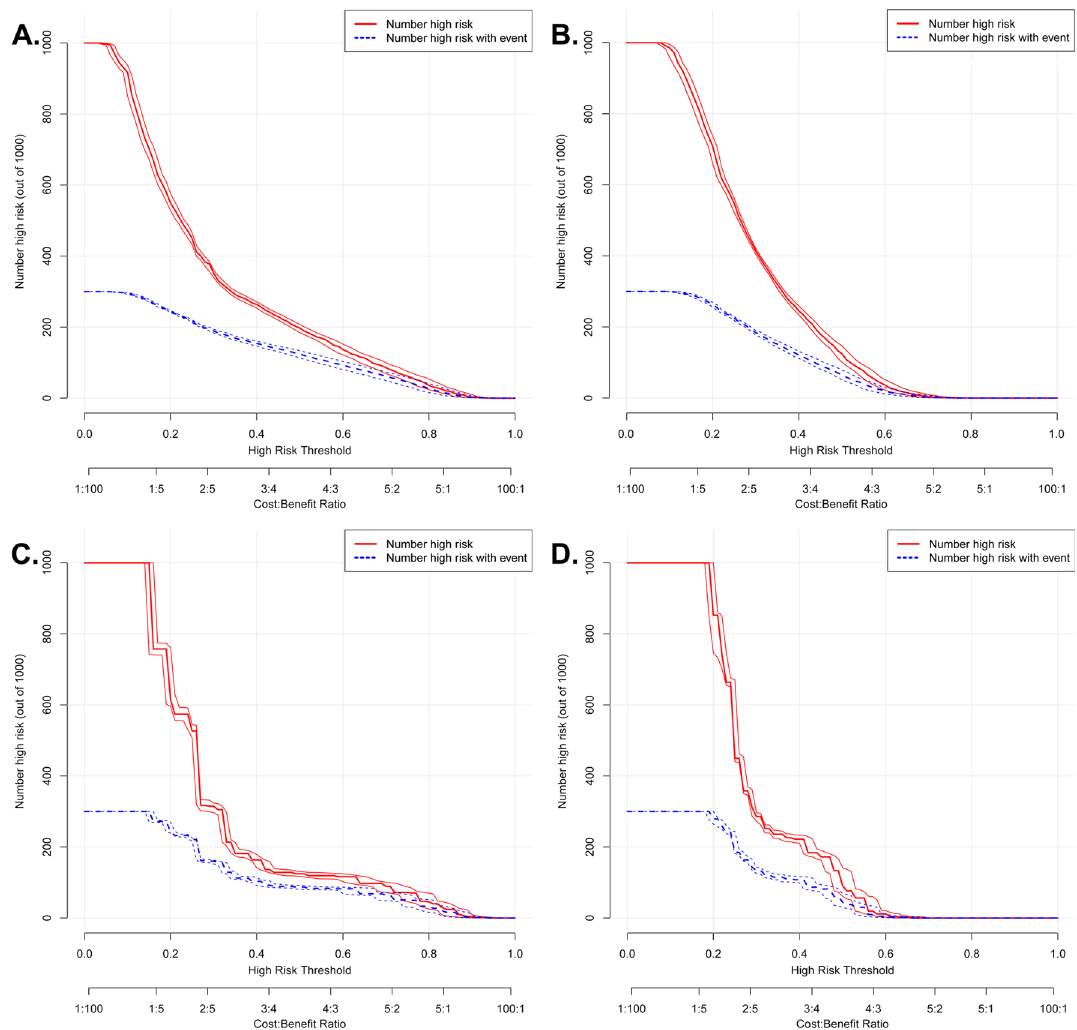
Figure 4. Clinical impact curve (CIC) detects the predictive value of two nomograms in GCC prognosis. ( A , B ) All variables nomogram. ( C , D ) TNM stage